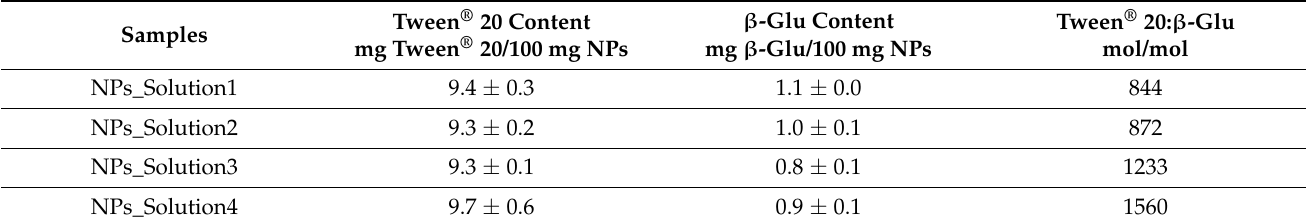
Table 5. Quantification of Tween ® 20 content in Nanoparticles formulated with solutions 1–4.